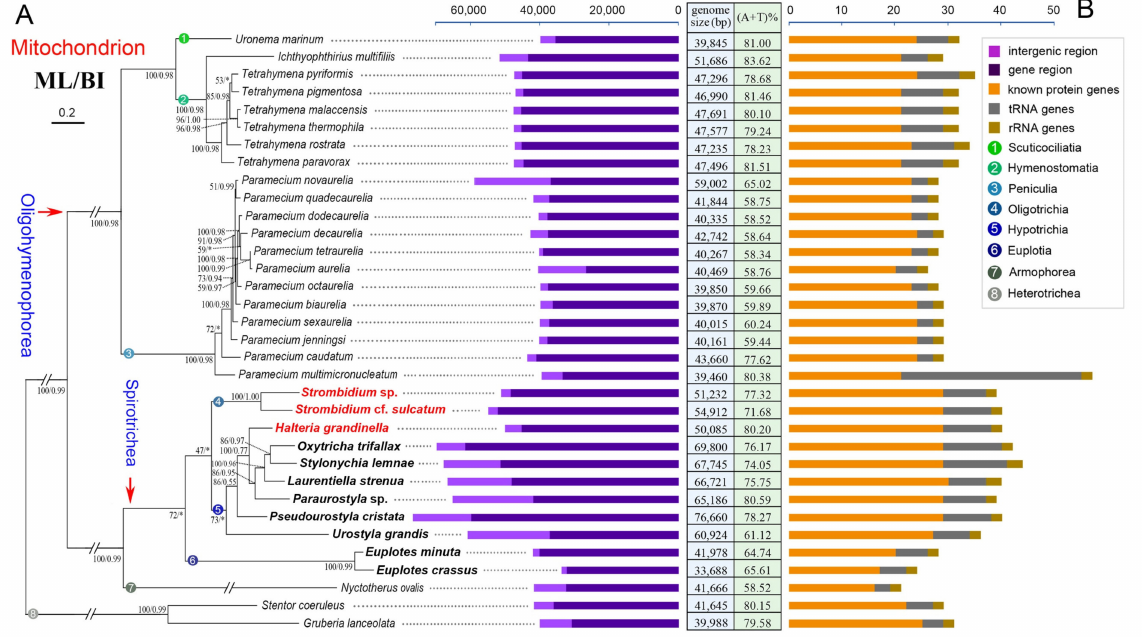
Figure 7. Phylogenetic analyses and main information of all the available mitogenomes in aerobic ciliates and a repre- sentative hydrogenosome genome in anaerobic ciliates. ( A ) Maximum likelihood (ML) tree based on the concatenated protein sequences of 14 mitochondrial orthologs of 34 available ciliates mitogenomes. Numbers at the nodes represent the standard nonparametric bootstrap values of ML out of 100 replicates and the posterior probability values of Bayesian analysis (BI). The asterisk “*” indicates the disagreement between ML and BI. The scale bar corresponds to 20 substitutions per 100 nucleotide positions. ( B ) Mitogenome and hydrogenosome information in 34 ciliate morphospecies. The left block indicates the length of the gene and intergenic regions, and the right block shows the number of the three kinds of genes,